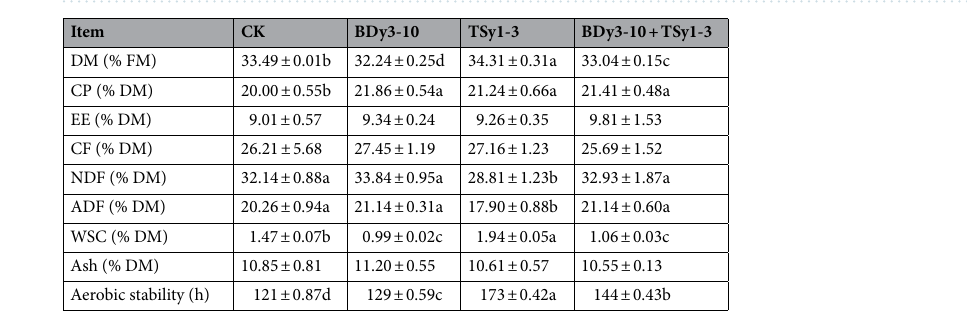
Figure 2. Polygenetic tree showing the relative positions of BDy3-10, TSy1-3 and related species, as inferred by the neighbor-joining method using complete 16S rRNA sequences.